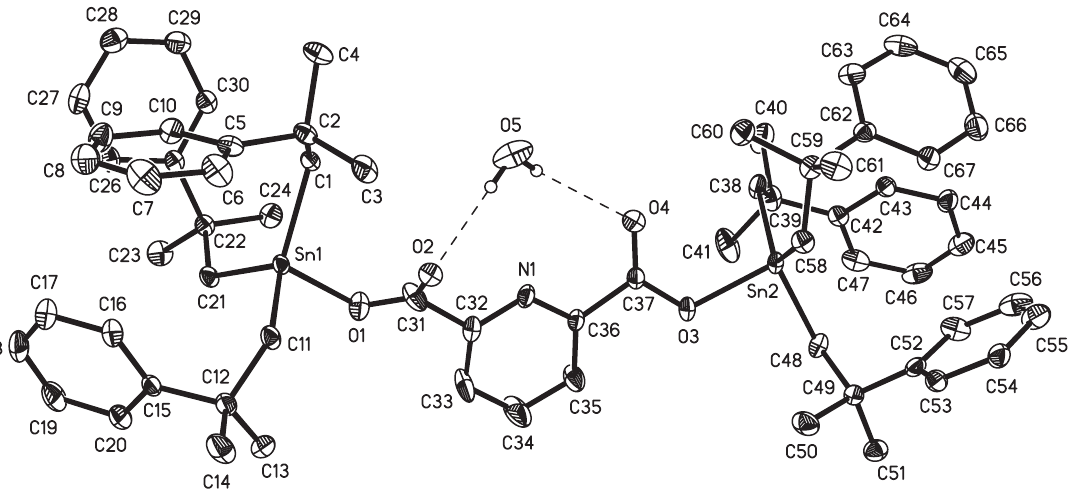
O with ellipsoids at the 30% probability level; except H atoms of water, the other H atoms are 2